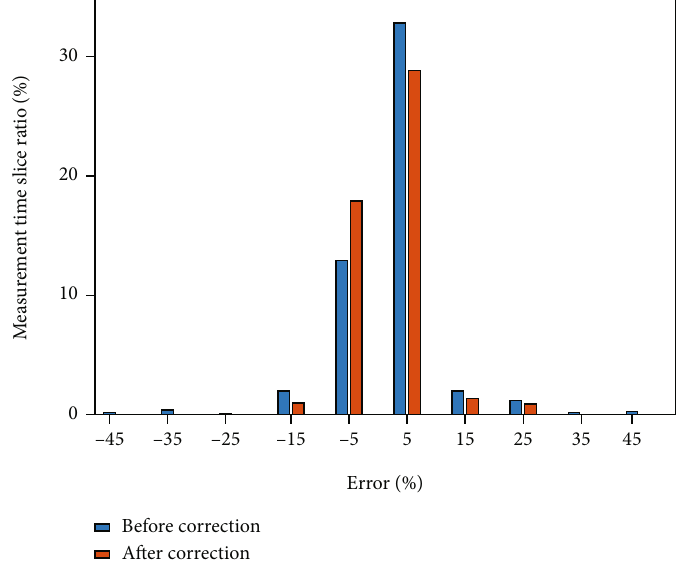
Figure 20: Prediction of error with and without